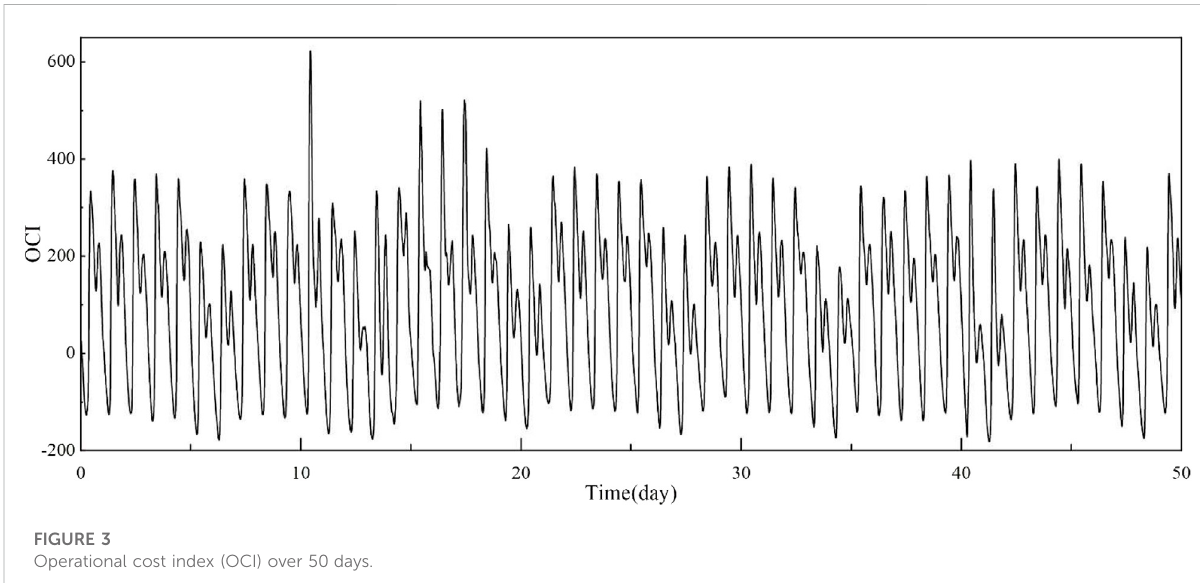
FIGURE 3 Operational cost index (OCI) over 50 days.